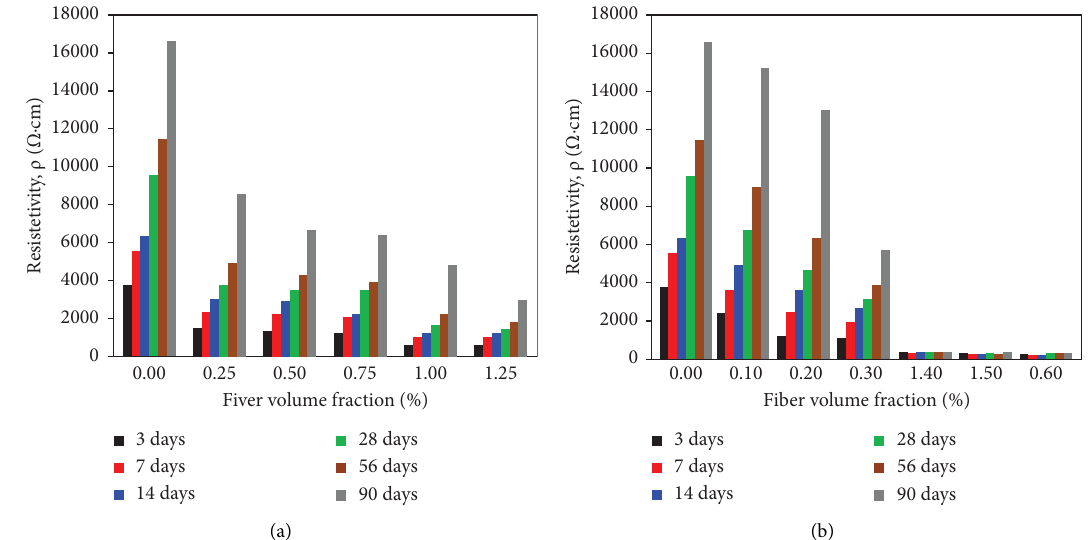
Figure 8: Electrical resistivity of conductive cement composites with diferent fber volume fractions. (a) SF specimens and (b) CF